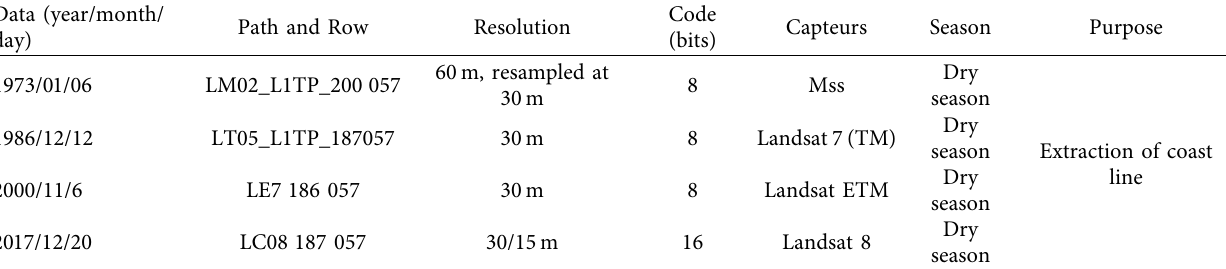
Table 2: Characteristics of images used.